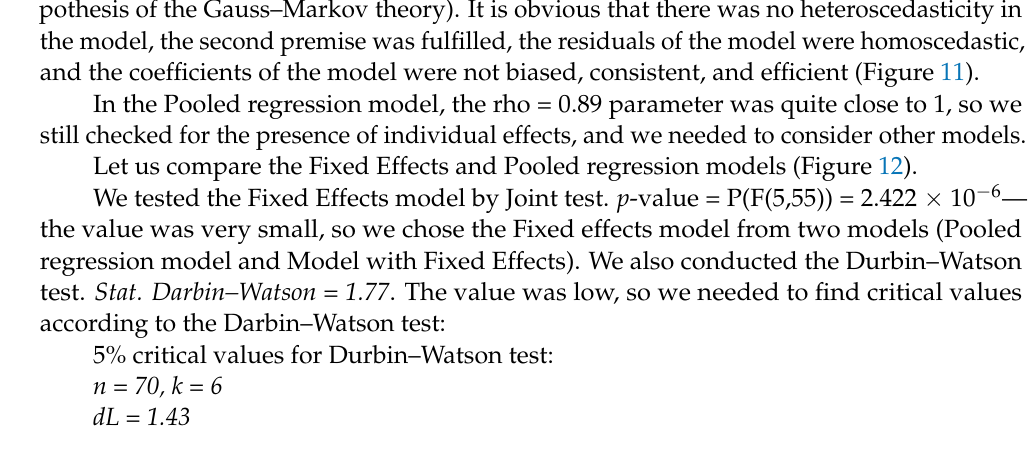
Figure 11. White’s test. In the Pooled regression model, the rho = 0.89 parameter was quite close to 1, so we still checked for the presence of individual e ff ects, and we needed to consider other mod- els. Let us compare the Fixed E ff ects and Pooled regression models (Figure 12).